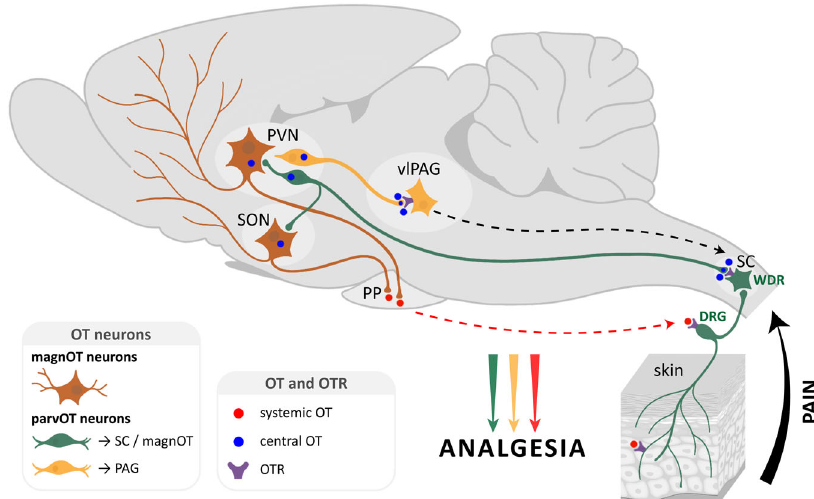
Fig. 7 | Two distinct ParvOT neuronal populations promote analgesia via releaseofOTinthevlPAGandinthebloodandspinalcord. Wehypothesizethat two parallel parvOT pathways are activated by pathological, painful